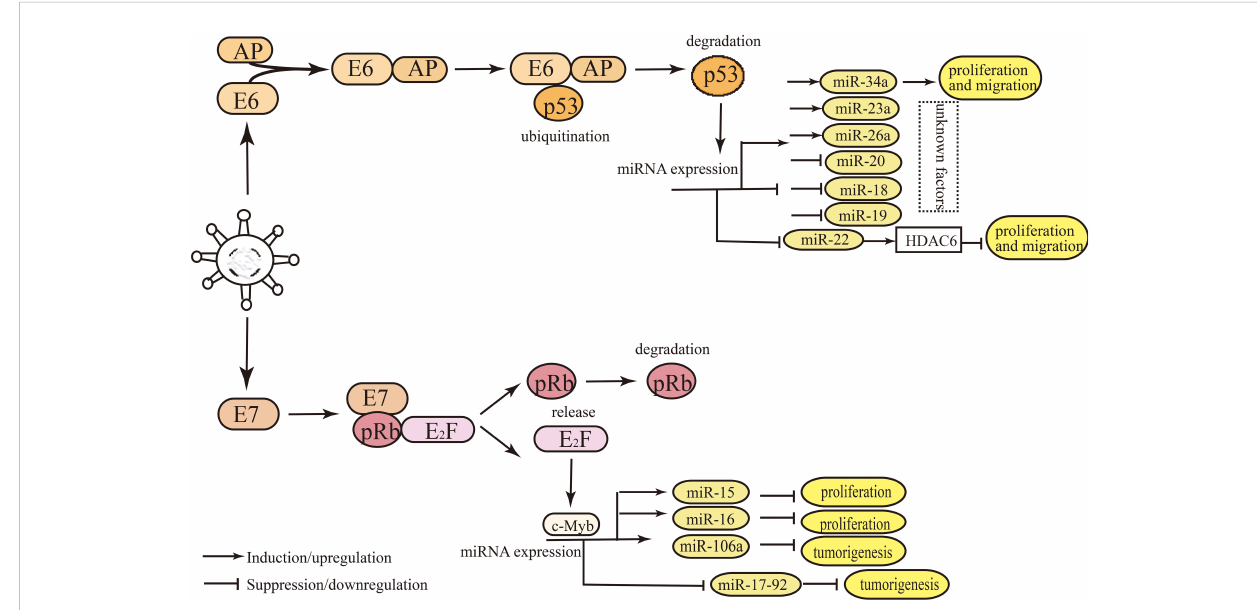
FIGURE 3 Main mechanisms of miRNAs expression regulation by E6/E7 in HPV-positive HNSCC and cervical cancer. E6 and E7 regulate the levels of miRNAs mainly by binding or releasing the transcription factors of miRNAs, such as c-Myc, p53, and E2F. The degradation of cellular transcription factor p53 is induced by E6, which can bind the promoter region of miRNAs. HPV E6 oncoprotein destabilizes p53, which contributes to the deregulated miRNAs. The degradation of pRb induced by E7 leads to the release of E2F from the pRB-E2F complex, and E2F binds to its binding site in miRNA promoter region, thus, affecting miRNA